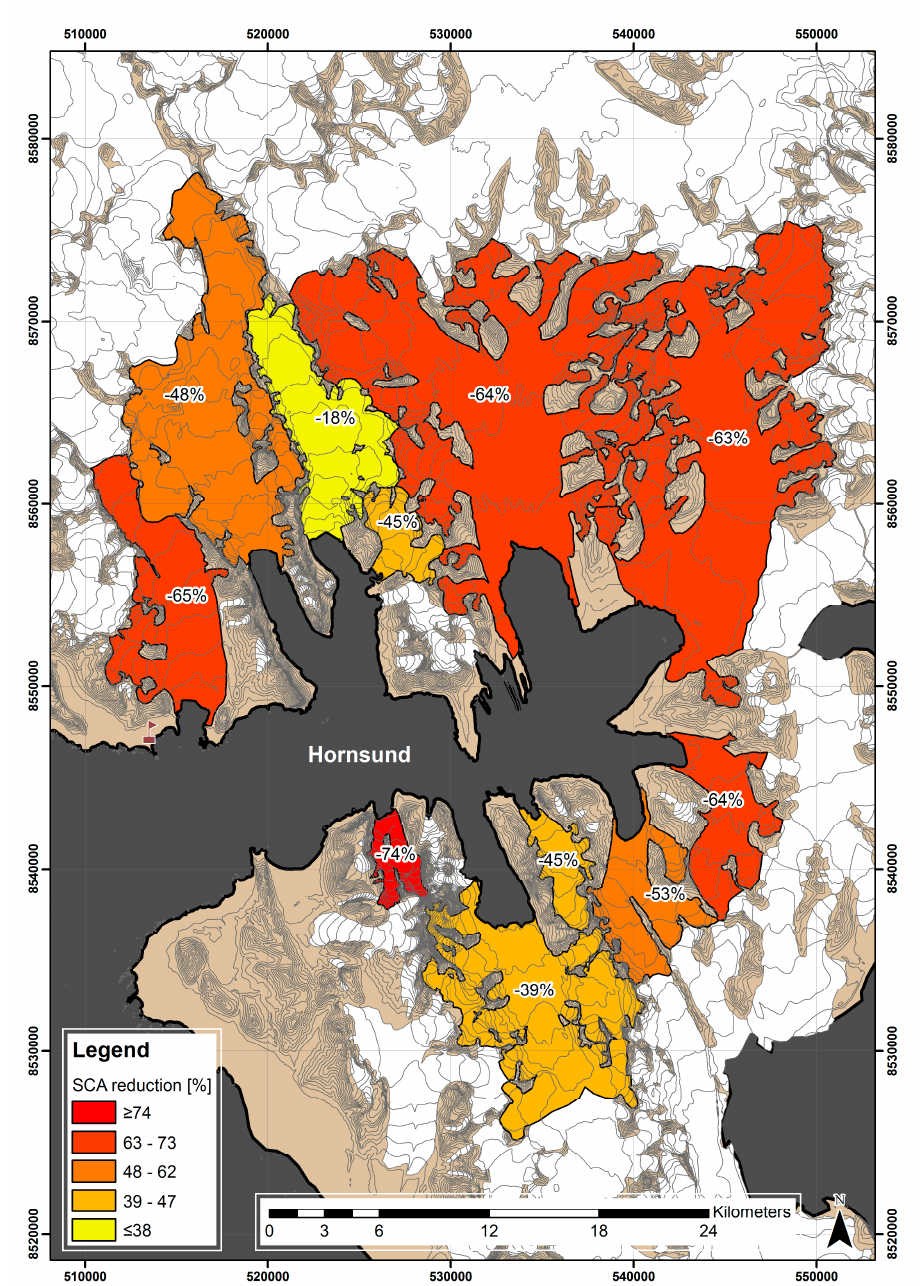
Figure 6. Reduction of the Snow-Covered Area (SCA) on the Hornsund glaciers analysed in the melting period of 2014.